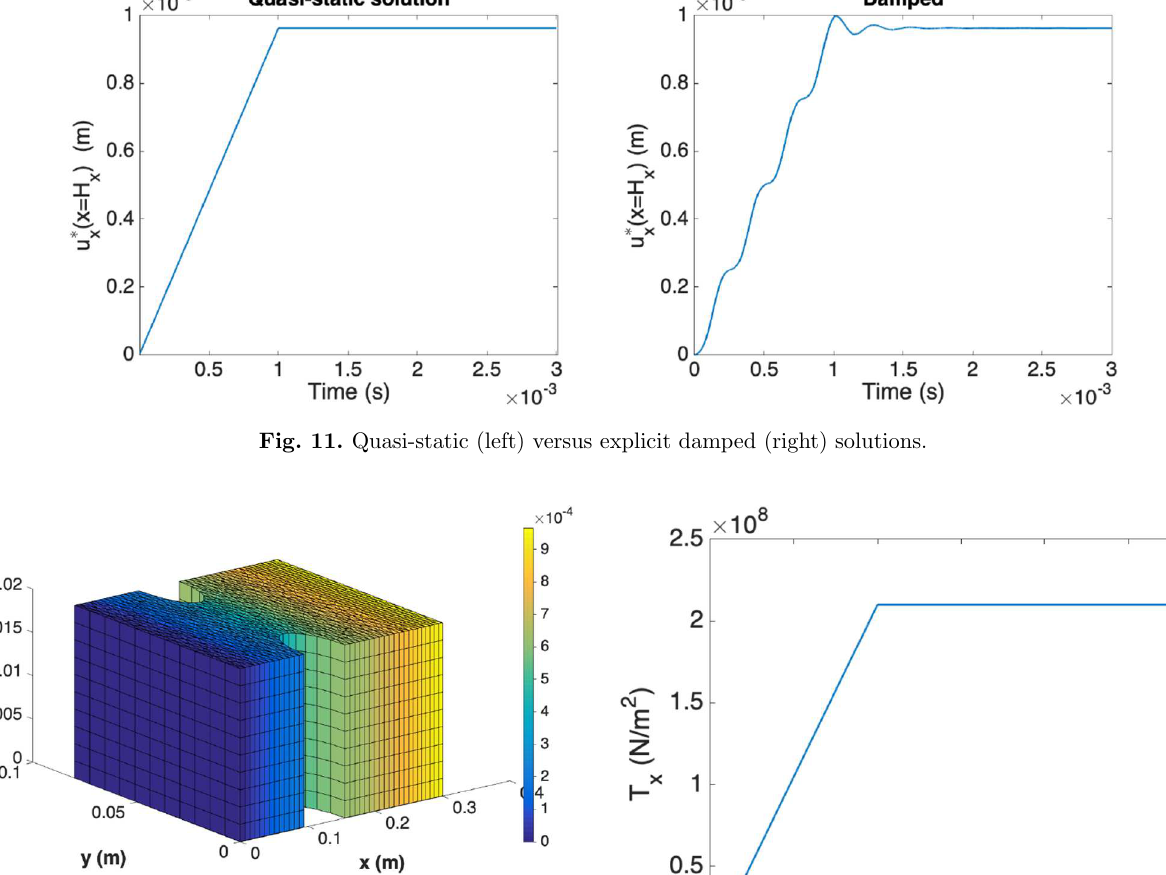
Fig. 12. Displacement field u x obtained at time t = 3 × 10 − 3 s.